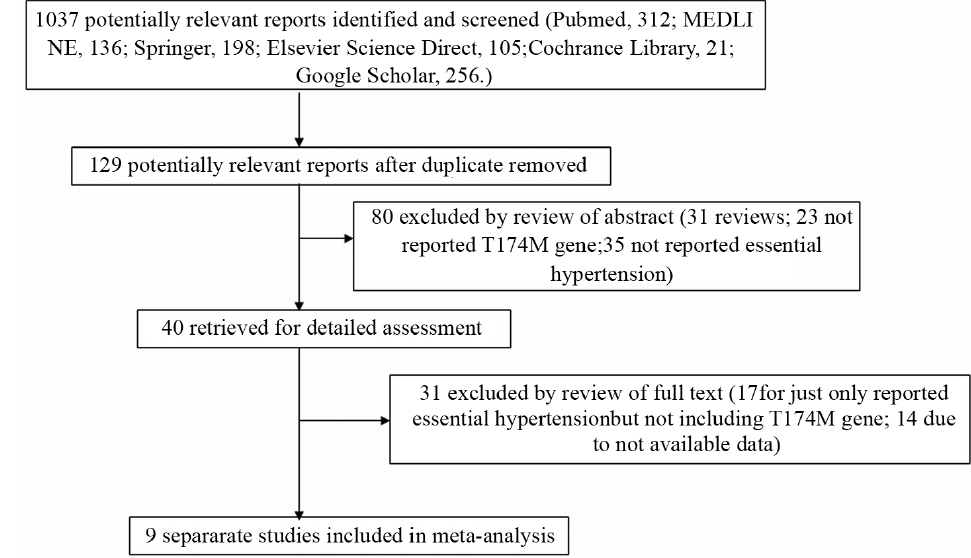
Figure 1 - Flowchart of the selection of studies for inclusion in the